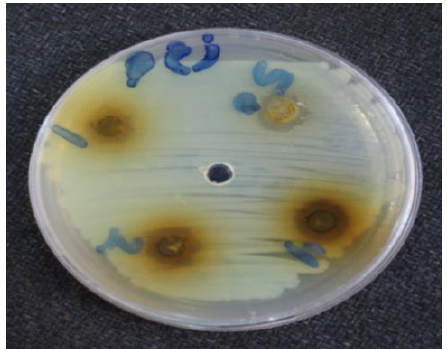
Figure, 7: Inhibition zones of Proteus spp. growth on Mueller-Hinton agar produced by ethanolic extract of Coriandrumsativum , the peripheral four wells contained extract concentrations ( 50, 100, 200, 400 mg/ml) whereas the central well contained 0.1 ml of 96% ethanol